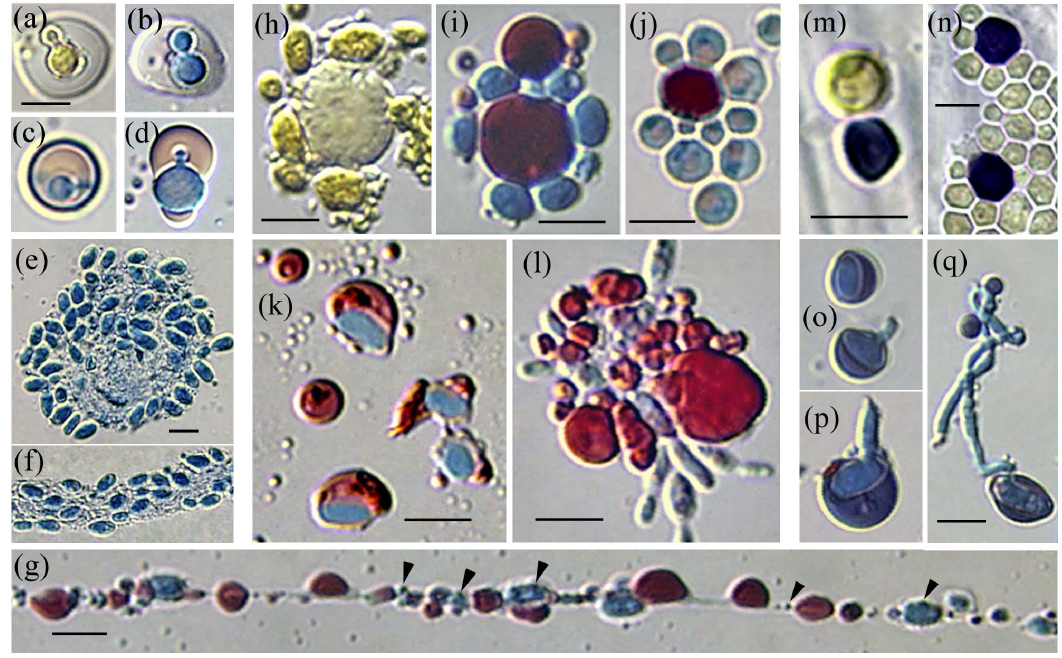
Figure 9. Mycosome reversion to walled cells. (a–d) Type II lipoid-Ms often contain budding yeast-like bodies that do not revert to parent cells. (a) Taphrina , MR stain. (b) Penicillium , AB stain. (c) Fusarium , AB/SIV stain. (d) Rhodotorula , AB/SIV stain. (e–f) Ms filtered from IAA-treated Rhodotorula formed walled yeast cells within spheroid (e) and filamentous (f) protoplasts. (g) IAA-treated Taphrina cells produced narrow filaments that formed lipoid-Ms and yeast cells, AB/SIV stain. (h–j) Walled cells develop from the margin of Type II lipoid-Ms: (h) Filobasidium , MR stain; (i) Rhodotorula and (j) Wickerhamomyces , AB/SIV stain. (k) Trichoderma conidia developed within lipoid-Ms, AB/SIV stain. (l) Taphrina yeast cells originating within a cluster of lipoid-Ms, AB/SIV stain. (m–n) Walled cells develop as division products of starch-producing Ms, MR stain. (m) A Penicillium conidium observed within an apple cell, MR stain. (n) Multipolar budding of Wickerhamomyces yeast from starch-Ms within a kiwifruit cell. (o–q) Cladosporium conidia germinate within mycosome PMOs. Bars =5.0 m